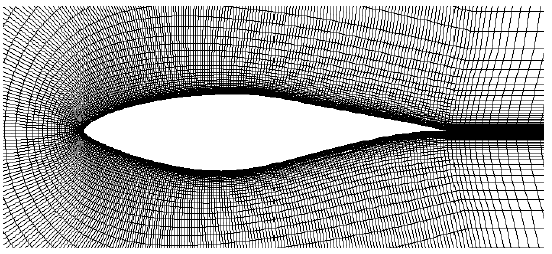
Figure 8. S809 mesh of training